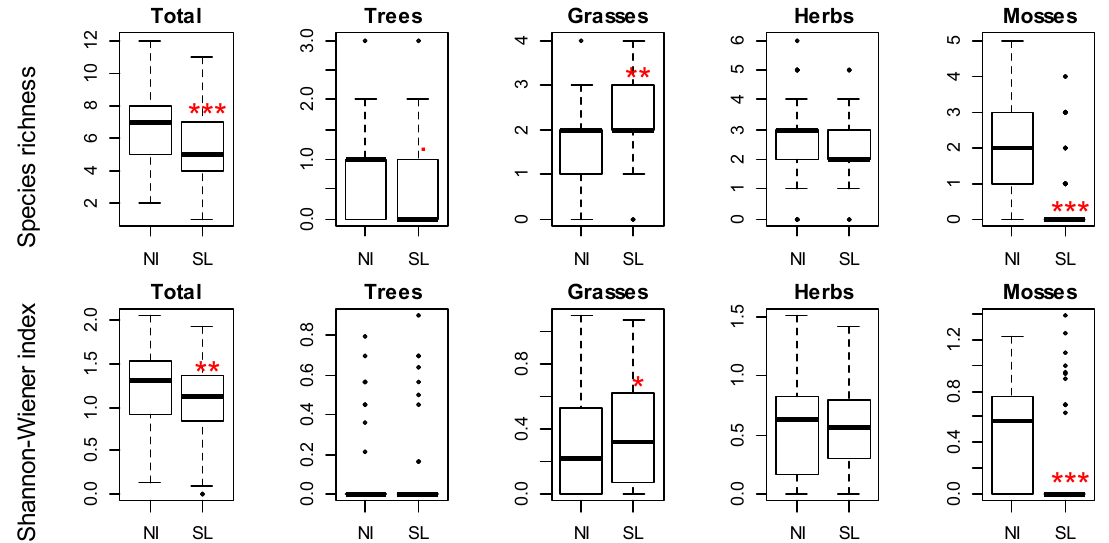
Figure 3. Boxplots presenting comparisons of species richness ( top row) and Shannon ‐ Wiener index ( bottom row) for all species pooled together (i.e., Total), for tree species, and for individual plant functional groups for both NI and SL sites (statistical significance: “***” p < 0.001, “**” p < 0.01, “*” p < 0.05, “.” p < 0.1).